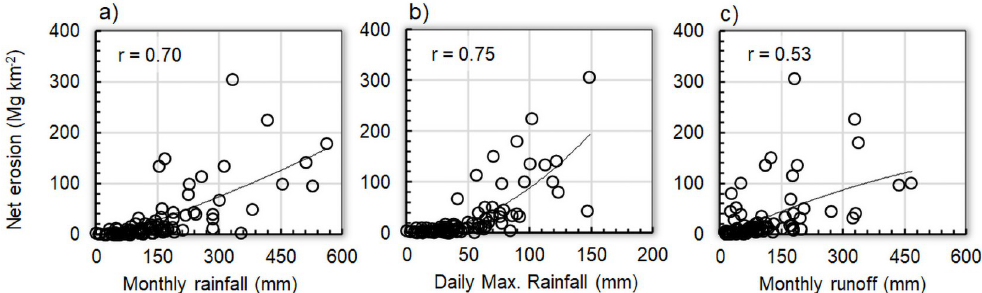
Fig 4. Polynomial regression modelling of monthly monthly net erosion as a function of alternative inputs. a) monthly amount of rainfall (Y = 1.28E-04 � X 2 +2.49E-01 � X-1.26E+01), b) daily maximum rainfall in each month (Y = 8.37E- 03 � X 2 +7.04E-02 � X-2.63E+00), c) monthly runoff (Y = -1.91E-04 � X 2 +3.67E-01 � X-5.80E+00).